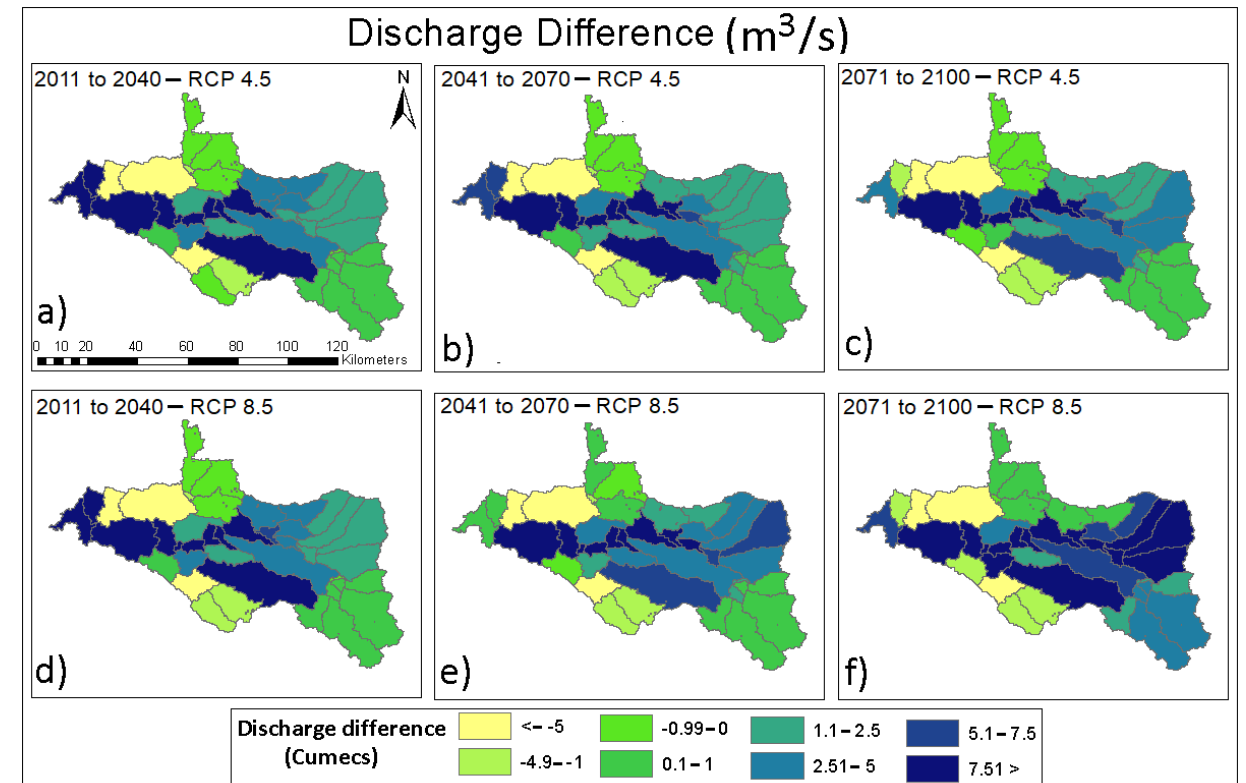
Figure 14. Spatial distribution of changes in the future streamflow, with respect to base period for three different time slices between 2011 to 2100, representing ( a ) RCP4.5 (2011 to 2040); ( b ) RCP4.5 (2041 to 2070); ( c ) RCP4.5 (2071 to 2100); ( d ) RCP8.5 (2011 to 2040); ( e ) RCP8.5 (2041 to 2070); ( f ) RCP8.5 (2071 to 2100). Table 6. Change in streamflow, due to climate change for RCP 4.5 and 8.5, as compared against the average value during the baseline period